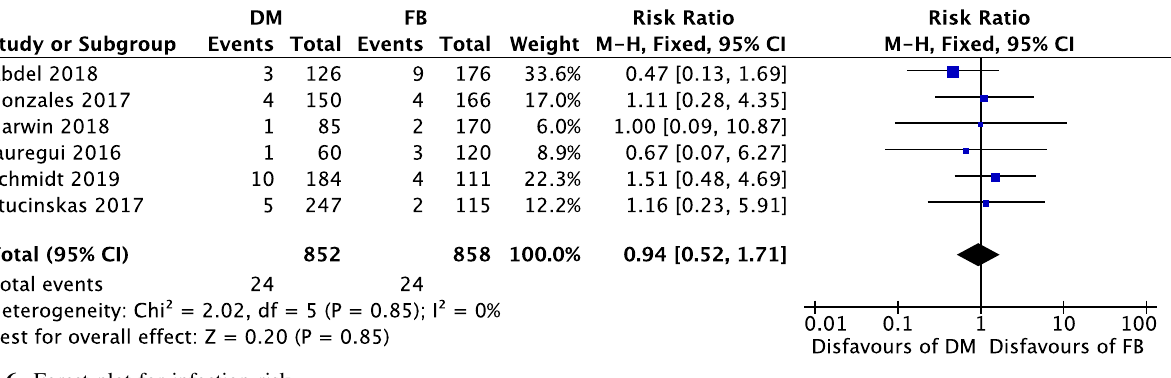
Figure 6. Forest plot for infection